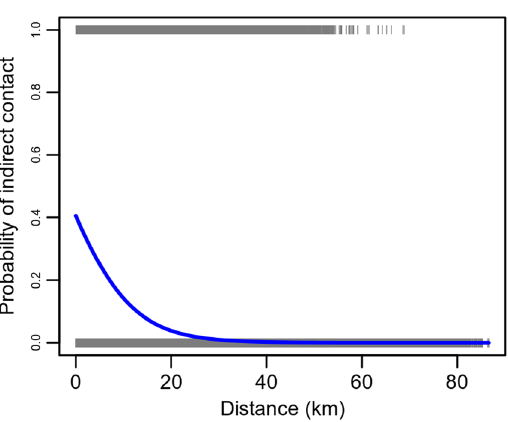
Figure 3. Epidemic simulations assuming one-contact-per-visit model. Results of the simulations comparing the full-information model (magenta), the model assuming only one contact generated by each visit (blue). Panel A: dashed lines represent the fraction of epidemics with secondary cases. Panel B: the distribution of the number of infected farms (crosses), with the median (thick line), and the 25 th and 75 th quantiles (dotted lines). h is set to 14 days.